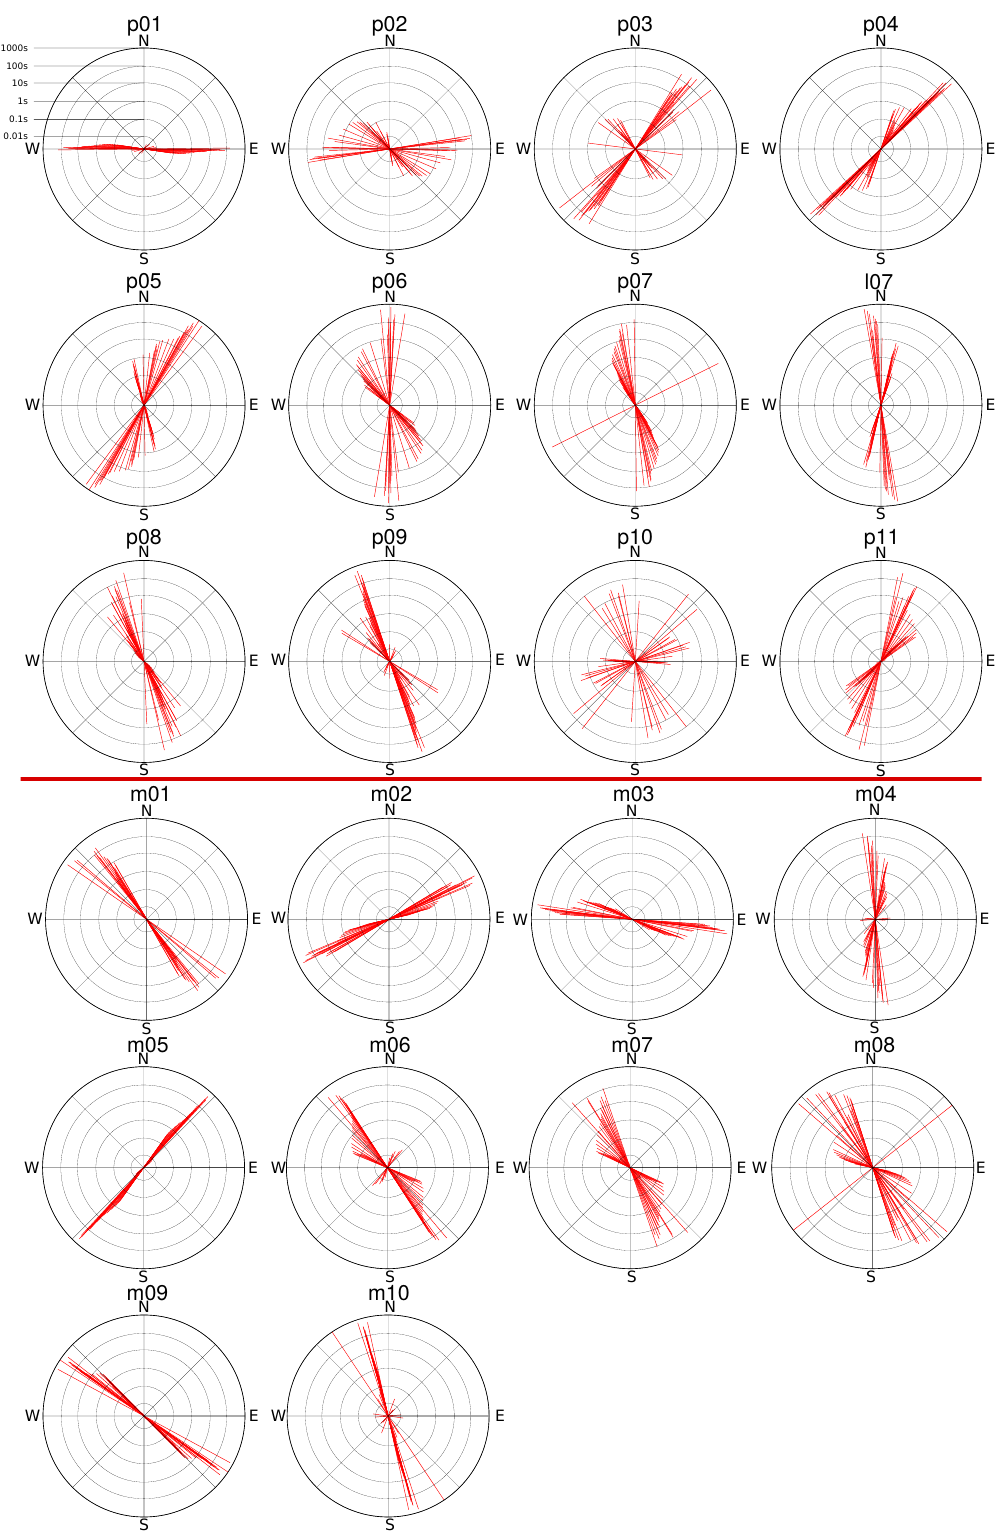
Figure A6. Rose diagram of the maximum electrical direction (MED) for all periods and all sites of the northern and southern profile. The circles represent the period scale (see diagram for site p01 for more details about the period